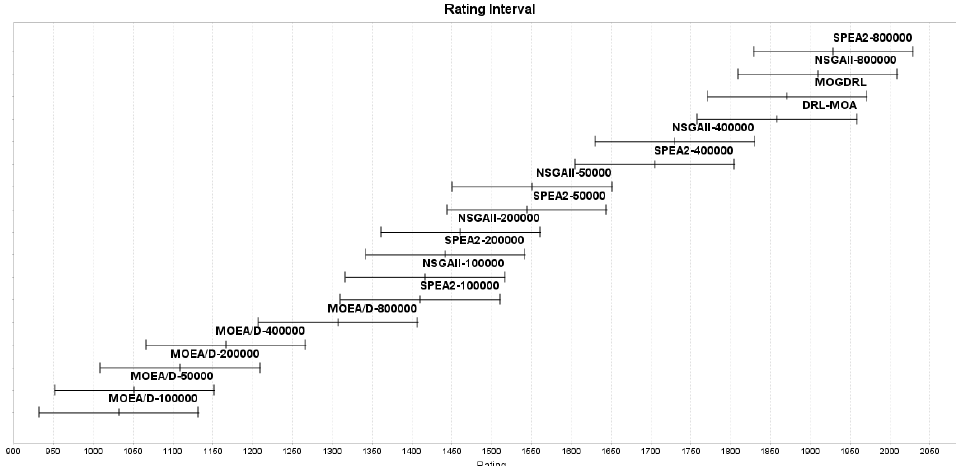
Figure 3. Hypervolume ranking results for 100 cities.